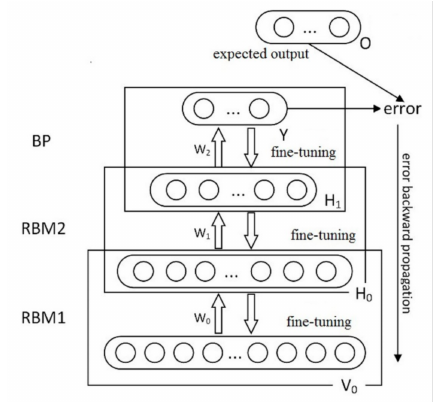
Figure 6. Deep belief network model